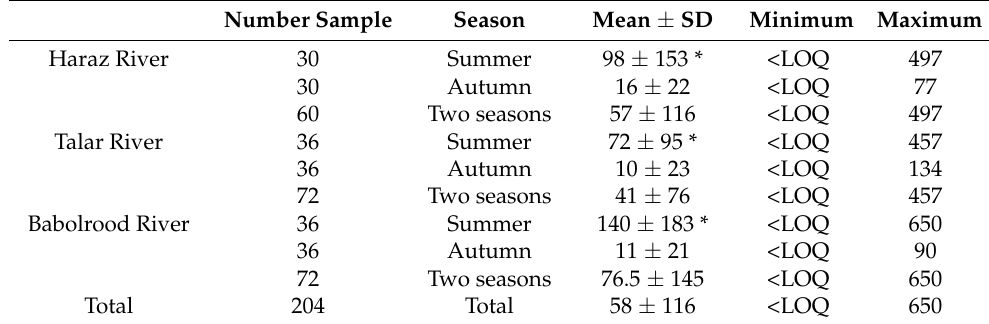
Table 1. Concentration of diazinon in the surface water of the Haraz, Talar and Babolrood rivers (ng/L). Number